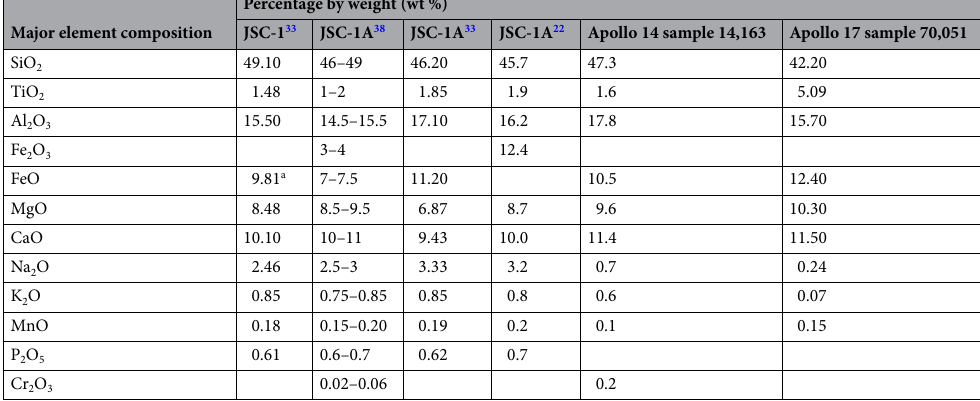
Table 1 summarises the bulk chemical compositions of JSC-1, JSC-1A (from different references), Apollo 14 and Apollo 17 lunar soil samples. The bulk chemical composition of JSC-1A closely matches that of the